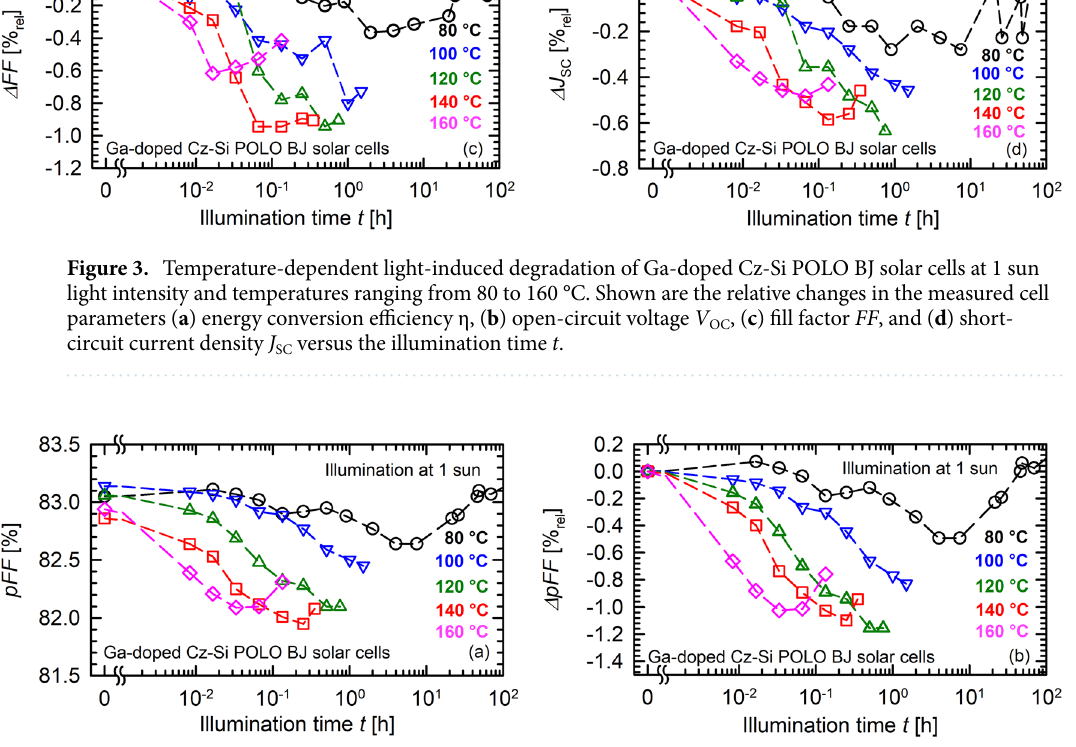
Figure 4. Temperature-dependent light-induced degradation of the pseudo fill factor pFF of Ga-doped Cz-Si POLO BJ solar cells at 1 sun light intensity and temperatures ranging from 80 to 160 °C. Shown are the absolute changes ( a ) and the relative changes ( b ) versus the illumination time t